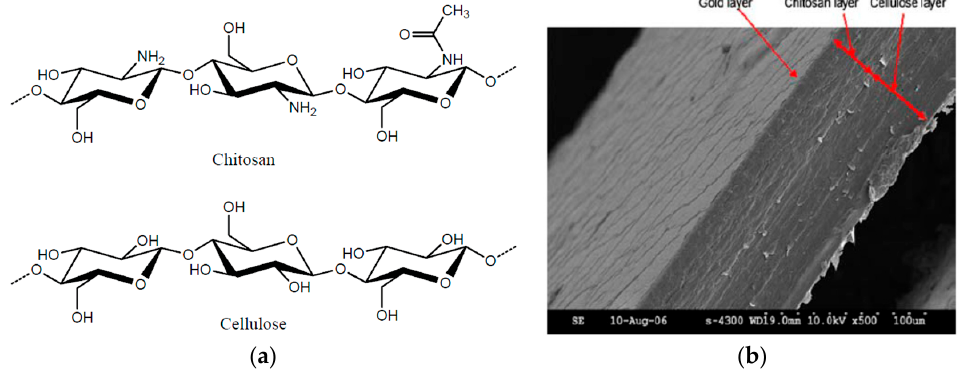
Figure 6. ( a ) Chemical structures of chitosan and cellulose [58]; ( b ) Scanning electron microscope image at the cross section of the laminated film [55].